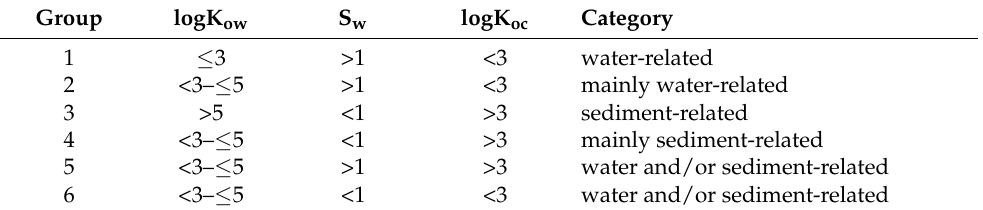
Table 4. Assessment of environmental fate, based on substances’